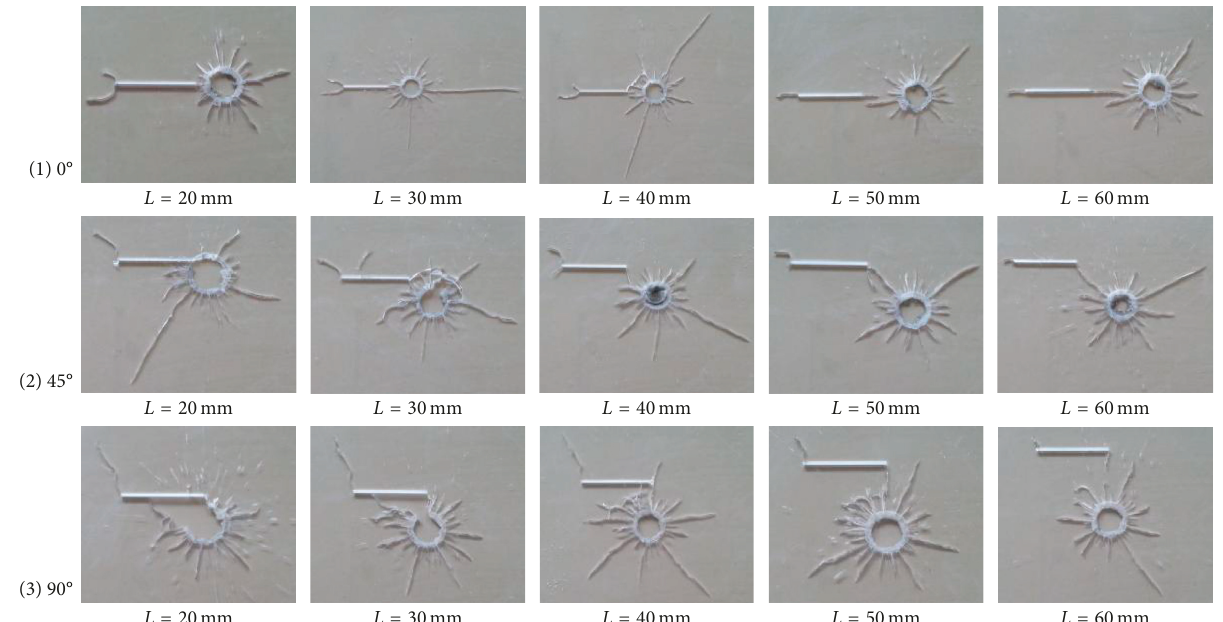
Figure 2: Air-filled PMMA specimens after